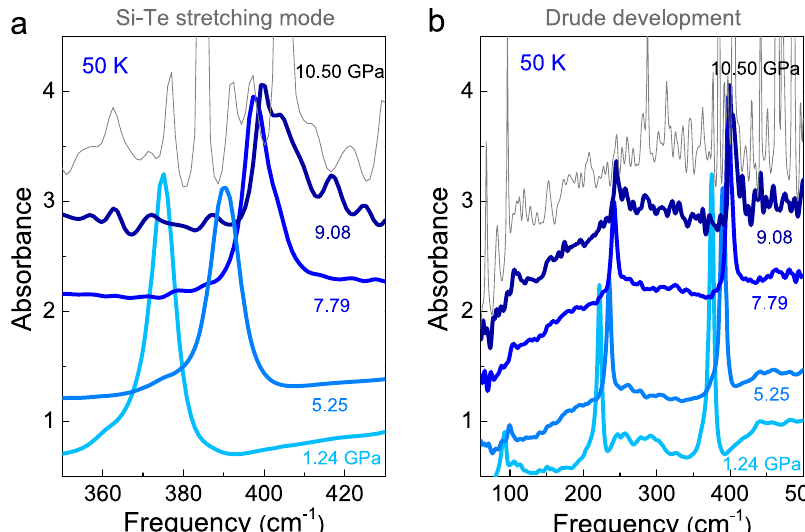
Fig. 2 Infrared response of CrSiTe 3 under extreme pressure – temperature conditions. a Close-up view of the infrared-active Si – Te stretching mode showing the development of the fi rst-order structural phase transition. The two-phase region becomes more sluggish with decreasing temperature. Oscillator fi ts are available in the Supporting information. b Spectral evidence for the insulator – metal transition due to closure of the indirect gap. The background is rising, and the phonons rise incompletely screened on top of the metallic background until the indirect gap closes and the signature of the phonons disappears due to screening by the Drude (indicated in gray). These spectra are on an absolute scale; they are not shifted in any